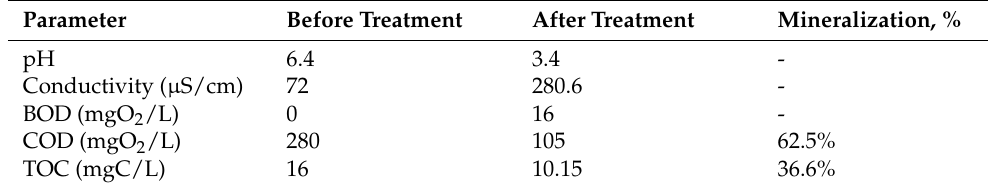
Table 4. The Results of the physico-chemical characterization of the effluent before and after treatment. Parameter Before Treatment After Treatment Mineralization, % pH 6.4 3.4 - Conductivity ( µ S/cm)